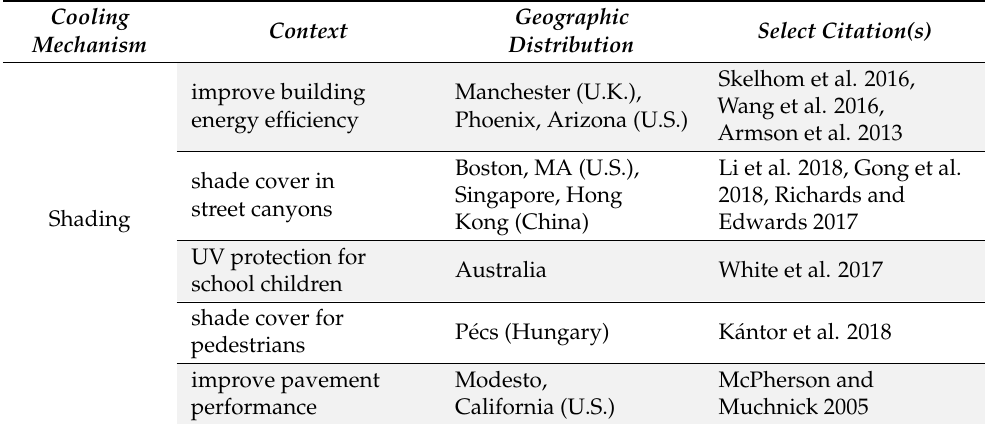
Table 4. Records addressing the cooling function of street trees. (Full listing available in Supplemen- tary